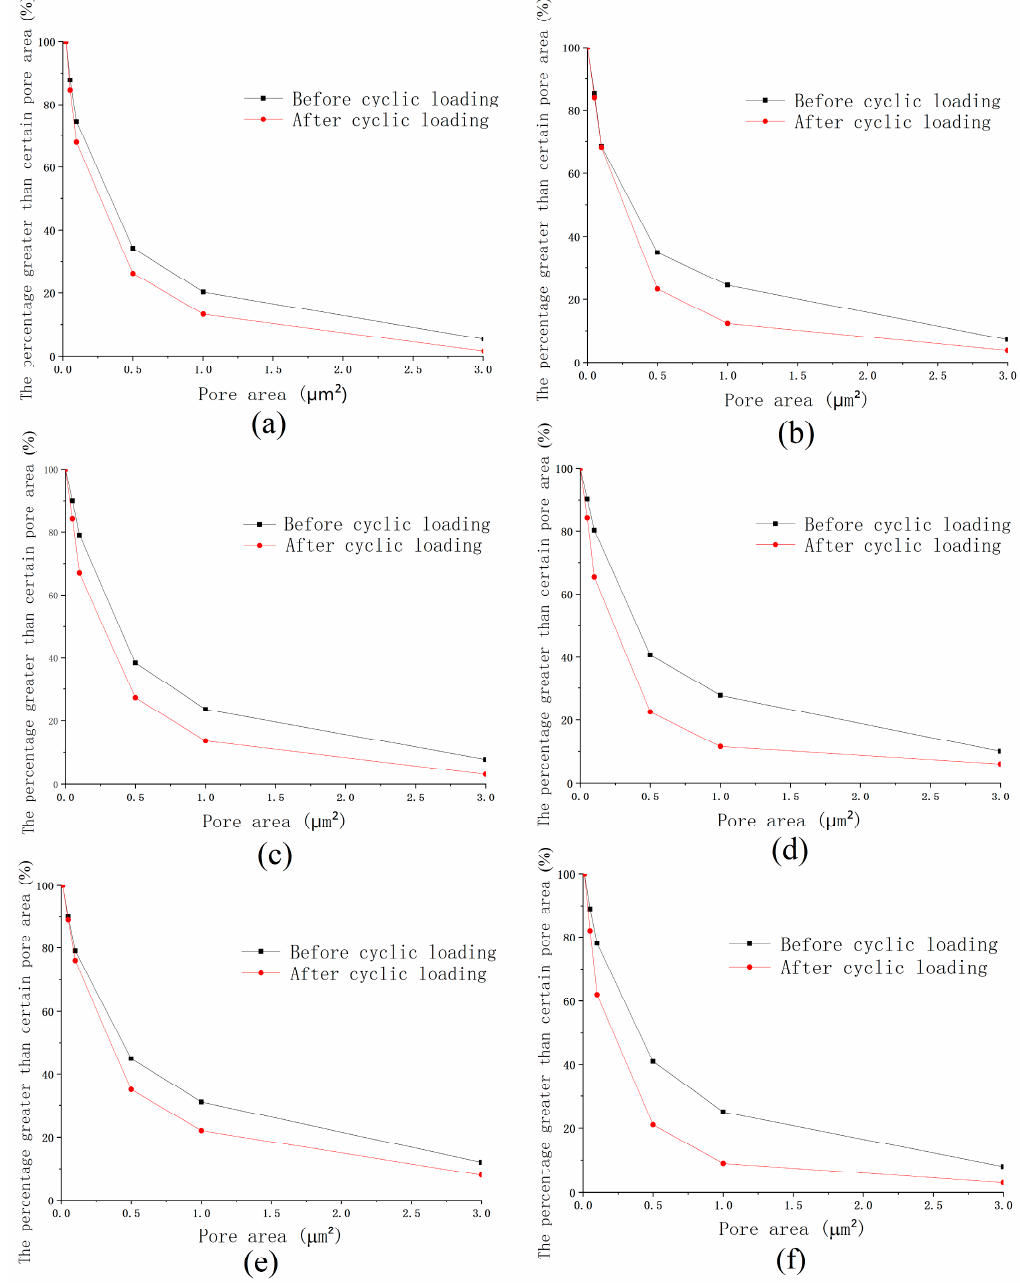
Figure 18. Cumulative distribution of pore area for ( a ) first-cycle frozen soil after loading at − 10 °C; ( b ) second-cycle frozen soil after loading at − 10 °C; ( c ) first-cycle frozen soil after loading at − 20 °C; ( d ) second-cycle frozen soil after loading at − 20 °C; ( e ) first-cycle frozen soil after loading at − 30 °C; ( f ) second-cycle frozen soil after loading at − 30 °C.